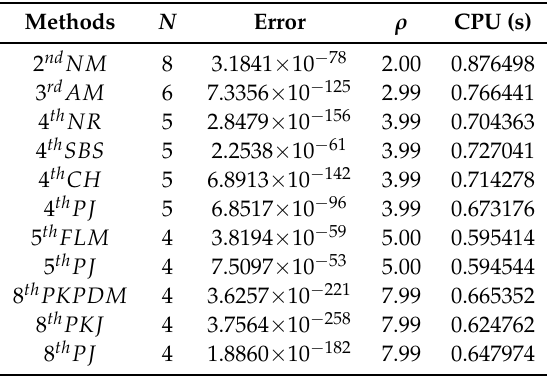
Table 8. Comparison of results for Application 5.